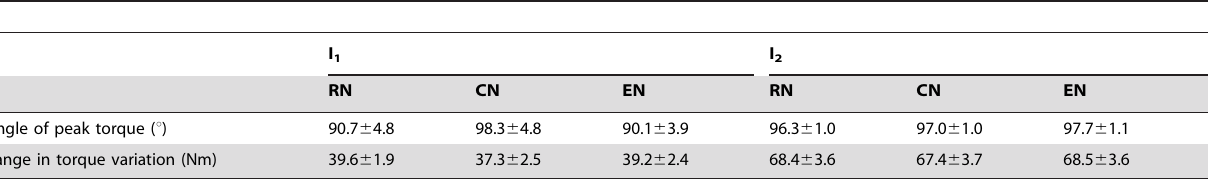
Table 2. Kinetic variables: Angle of peak torque and range in torque variation (mean 6 SEM) recorded over a complete crank cycle during interval 1 (I 1 ) and interval 2 (I 2 ) of the Wingate test performed the following morning after 3 different nights.